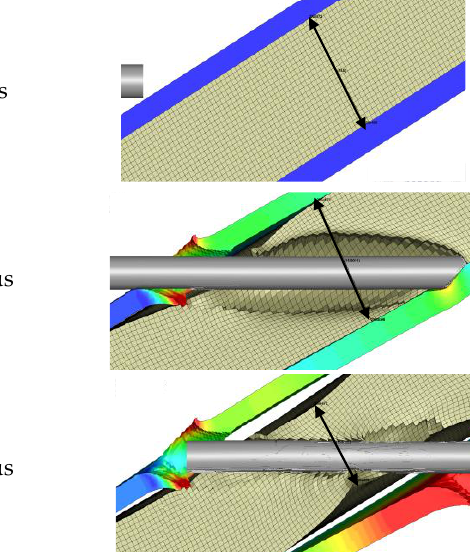
Figure 12. Changes in the rubber thickness during the target penetration. While the long-rod projectiles traverse the rubber, the rubber expands quickly, in- creasing its thickness to 16.5 mm — the maximal value for the analysed cross-section reached when the whole rubber layer is perforated and the KEP hits the back plates, Fig- ure 12. Then, the coating starts to shrink, and it is thinning to 11 mm obtained when the rod is tightly enfolded by the whole rubber layer, at 55 µs. Figure 8b allows noticing that this is the time instant that proceeds the moment of the crack initiation in the rod. After- wards, the rubber almost retreats its initial thickness. The deformation of the rubber is followed by the plates ’ deformation, which is discussed in the next paragraph.